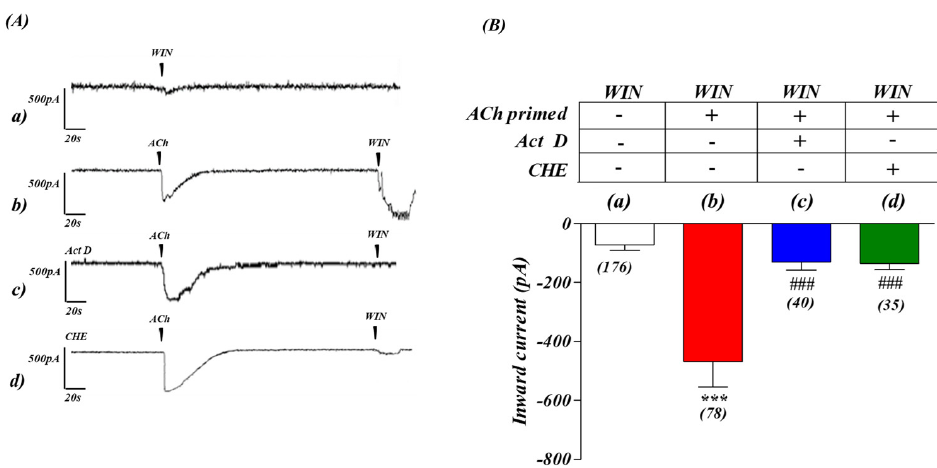
Figure 2. ACh ‘priming’-enhanced inward current responses to CB 1 receptor activation in SH − SY5Y human neuroblastoma cells involves transcription and protein synthesis. ( A ) Whole cell voltage- clamp recordings from SH − SY5Y cells in culture. The basal inward current induced by WIN 55,212 − 2 ( a ) was greatly enhanced after 5 min pre-application of acetylcholine (ACh, 1 µ M) ( b ). The ACh − dependent priming enhancement of CB 1 receptor responses was abolished by 30 min pre-treatment with RNA polymerase inhibitor actinomycin D (Act D, 1 mM) ( c ) or with protein synthesis inhibitor cycloheximide (CHE, 10 nM) ( d ) ( B ) Histogram representation of the M 3 receptor priming on the subsequent cellular response induced by CB 1 receptor stimulation in presence of Act D ( c ), and CHE ( d ). *** p < 0.001 vs. ( a ) WIN only, and ### p < 0.001 vs. ( b ) ACh − WIN. One − way analysis of variance followed by Multiple Comparison Test with Bonferroni’s correction. n values for each experiment are shown in brackets below each bar.